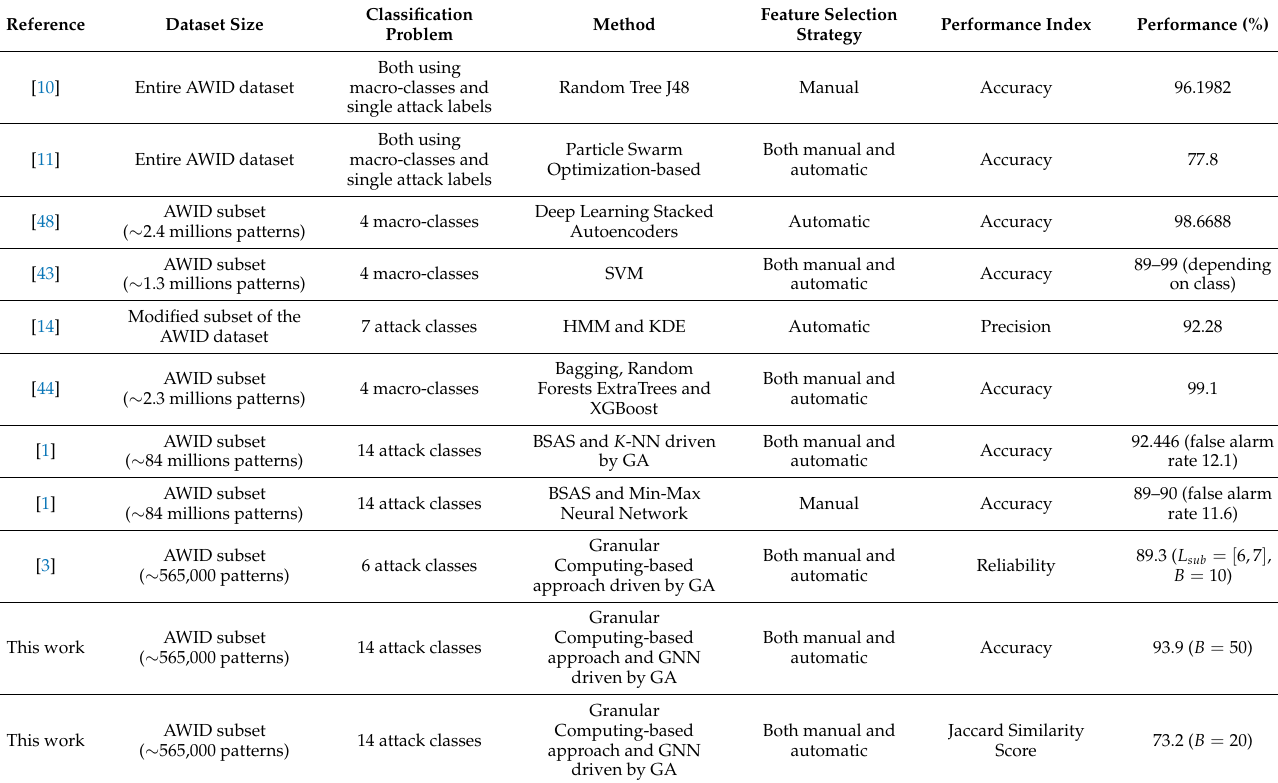
Table 6. Performance comparison with related state-of-the-art